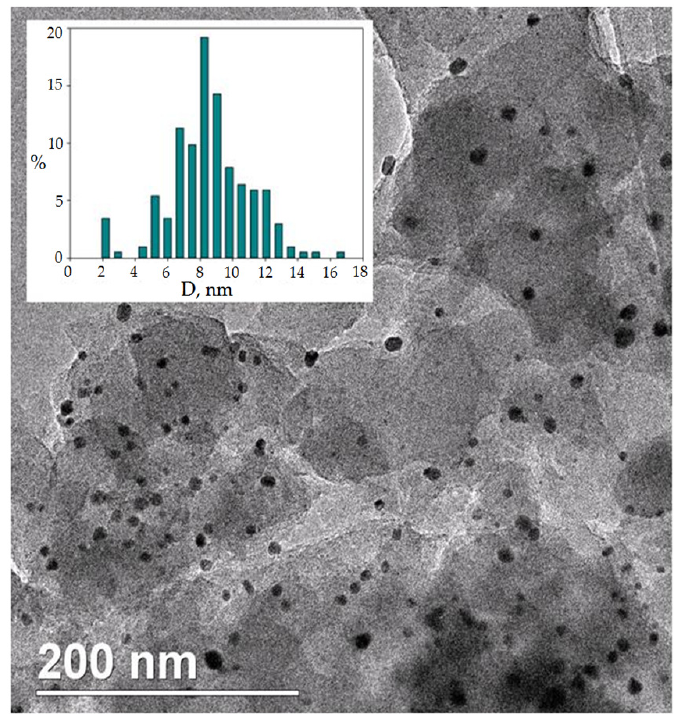
Figure 2. S/TEM image of Pd(0)/HPS.